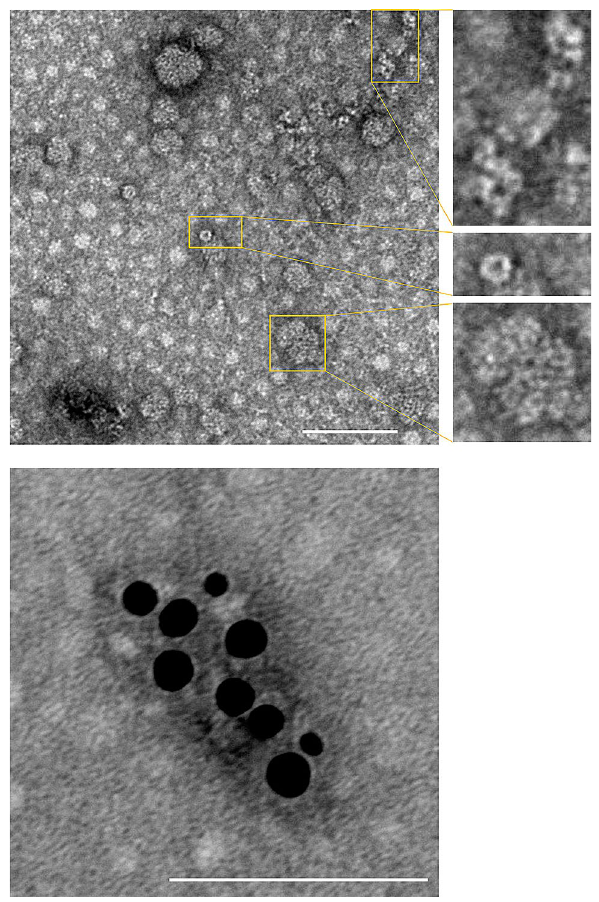
Figure 3. Electron micrographs of purified CCHFV NP. Purified CCHFV NP fractions were dialyzed overnight against TBS and then concentrated. Helical (upper right top panel), ring (upper right middle panel), and aggregated forms (upper right bottom panel) of the NP structures are shown. Polyclonal goat anti-rabbit IgG antibodies labeled with 5 nm gold particles were used for immunoelectron microscopy (bottom panel). TEM was operated at 80 kV, 1.0 µm, × 24.0 k magnification. Scale bars represent 100